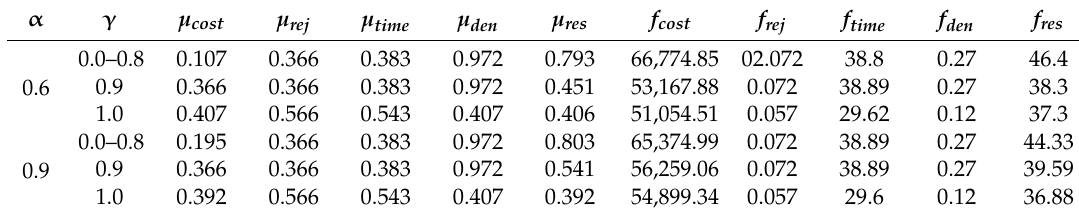
Table 8. Sensitivity analysis of Werners’ ‘fuzzy and’ operator.